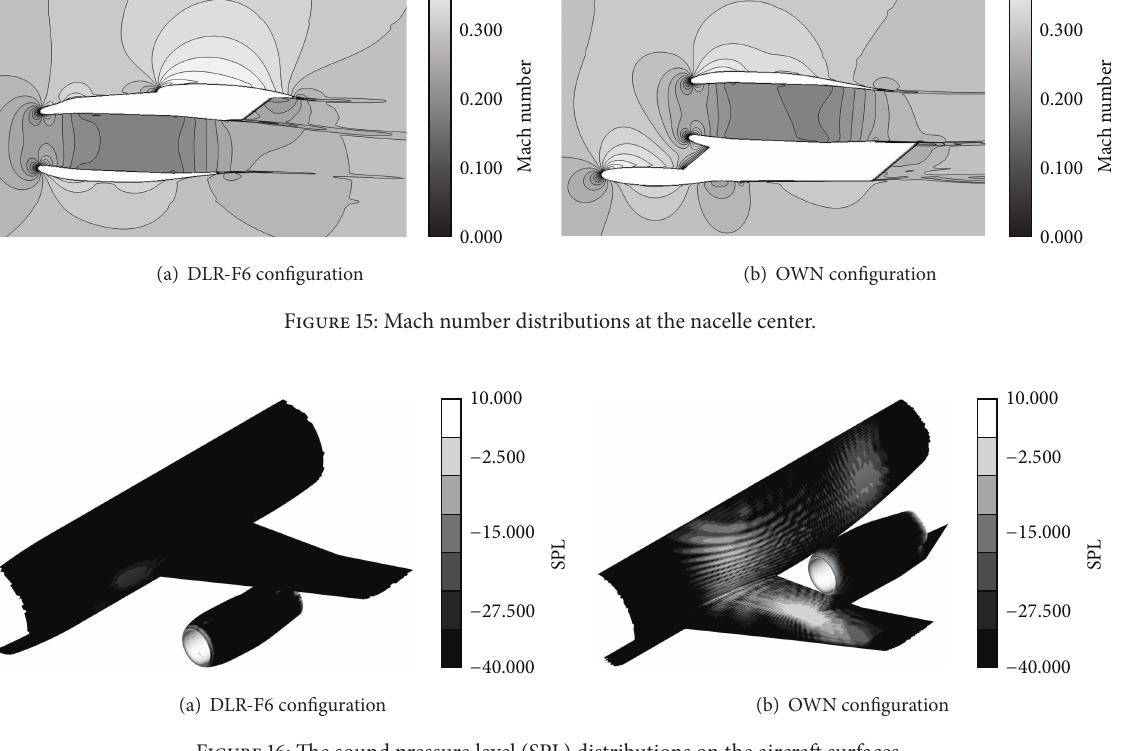
Figure 16: The sound pressure level (SPL) distributions on the aircraft